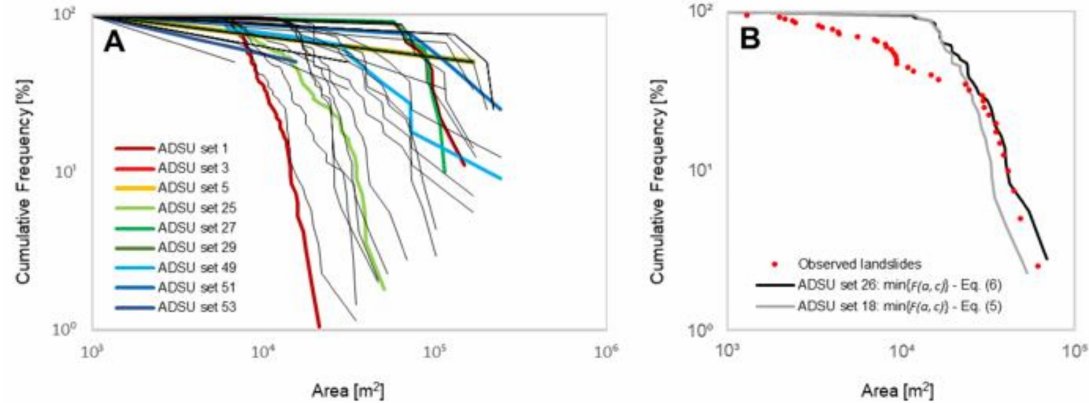
Figure 7. ( A ) Cumulative frequency size distributions of the active deformation slope unit (ADSU) maps for all the possible combinations of the software r.slopeunits [47] input parameters a and c . The highlighted results are listed and described in the text. ( B ) Cumulative frequency size distributions of the inventoried landslides, the ADSU set corresponding to the minimum value of the metric F ( a, c ) defined by Equation (6) (ADSU set 26), and the optimal ADSU set (ADSU set 18), corresponding to the minimum value of the metric F ( a, c ) defined by Equation